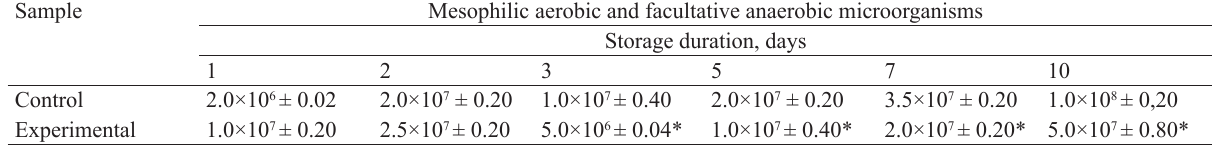
Table 8 Total bacterial count in pork during 10-day storage Sample